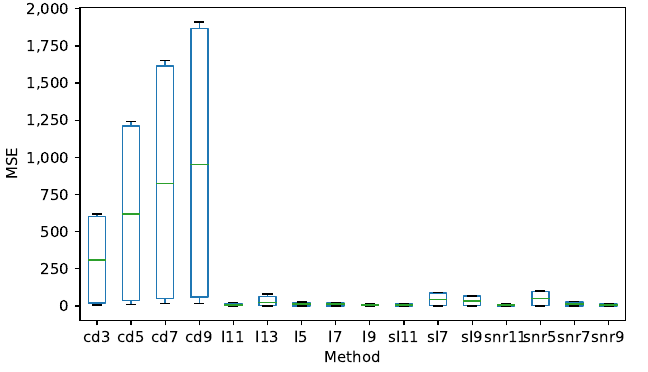
Figure 2. Errors introduced by differentiation methods measured using the Mean Squared Er- ror (MSE).